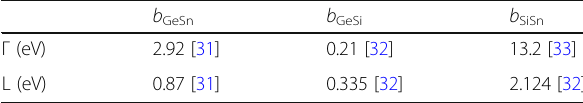
Table 1 Binary alloy ’ s bandgap bowing parameters in